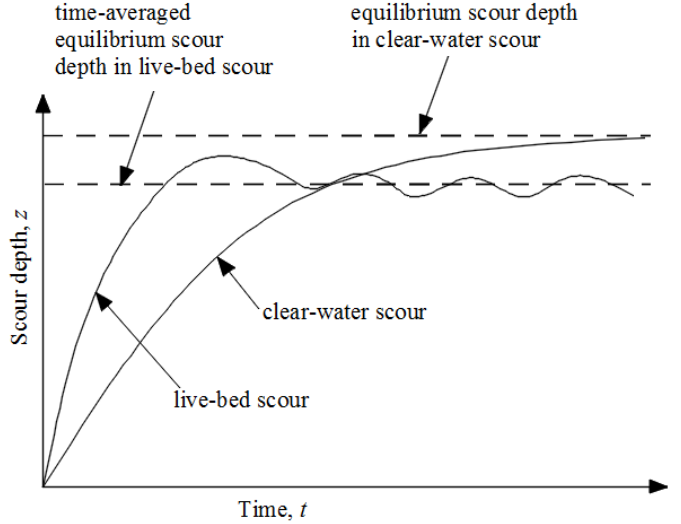
Figure 1. Time development of clear-water and live-bed scour [10].